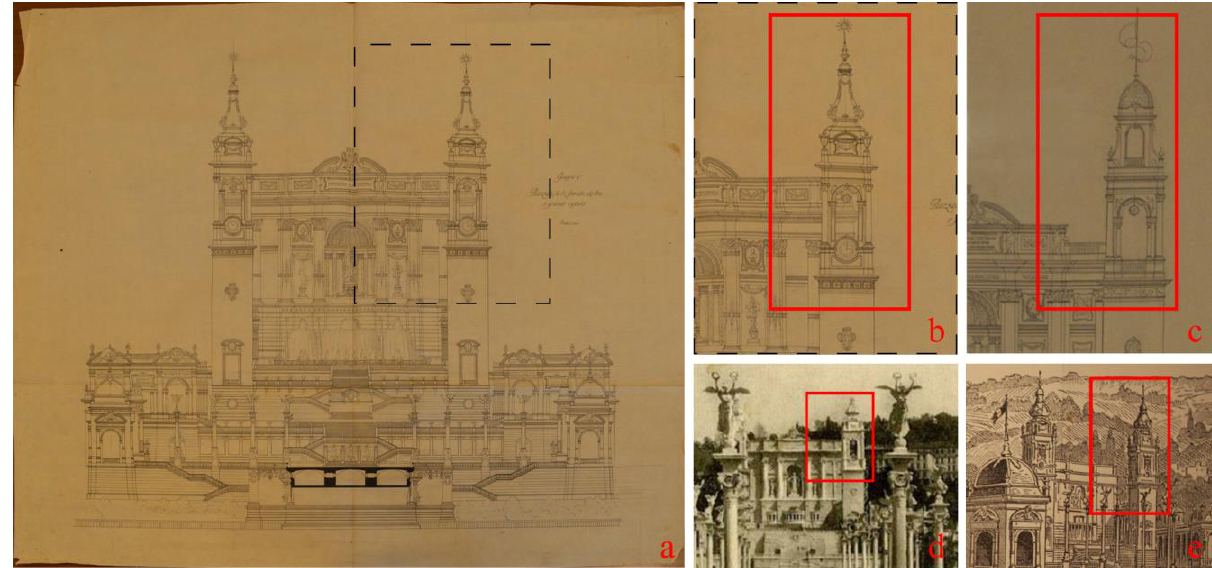
Figure 7. Comparison of different sources: (a) Elevation of the Monumental complex, original scale 1:100 (Fondazione Marazza, Archivio Stefano Molli), (b) zoom on the tower top and ledge, (c) same elevation in another drawing at original scale of 1:200 (Fondazione Marazza, Archivio Stefano Molli, (d) photo excerpt (CDC private collection), sketch excerpt (Exposition,